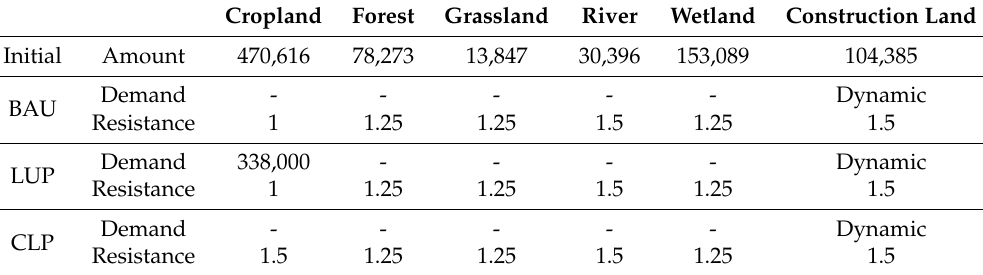
Table 2. The demands and resistances of land uses in di ff erent